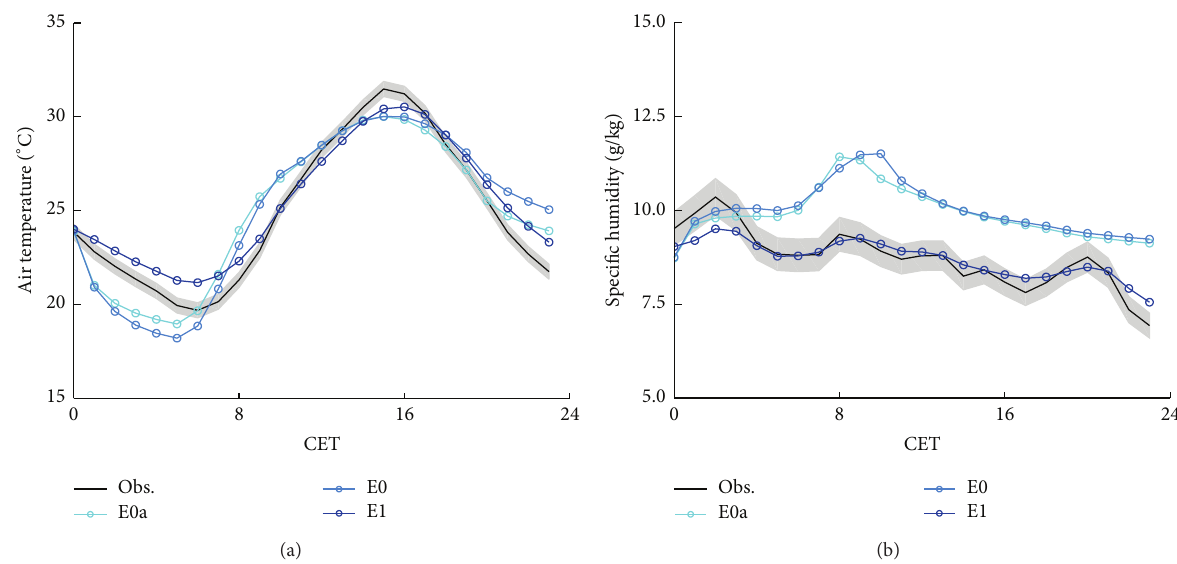
Figure 8: Comparison of simulated and observed (a) air temperatures and (b) specific humidity of the experiments with ENVI-met 3 (E0a) and unforced and forced ENVI-met 4 (E0 and E1) on 7, 23, 2013. The gray area indicates the accuracy range of the observations.